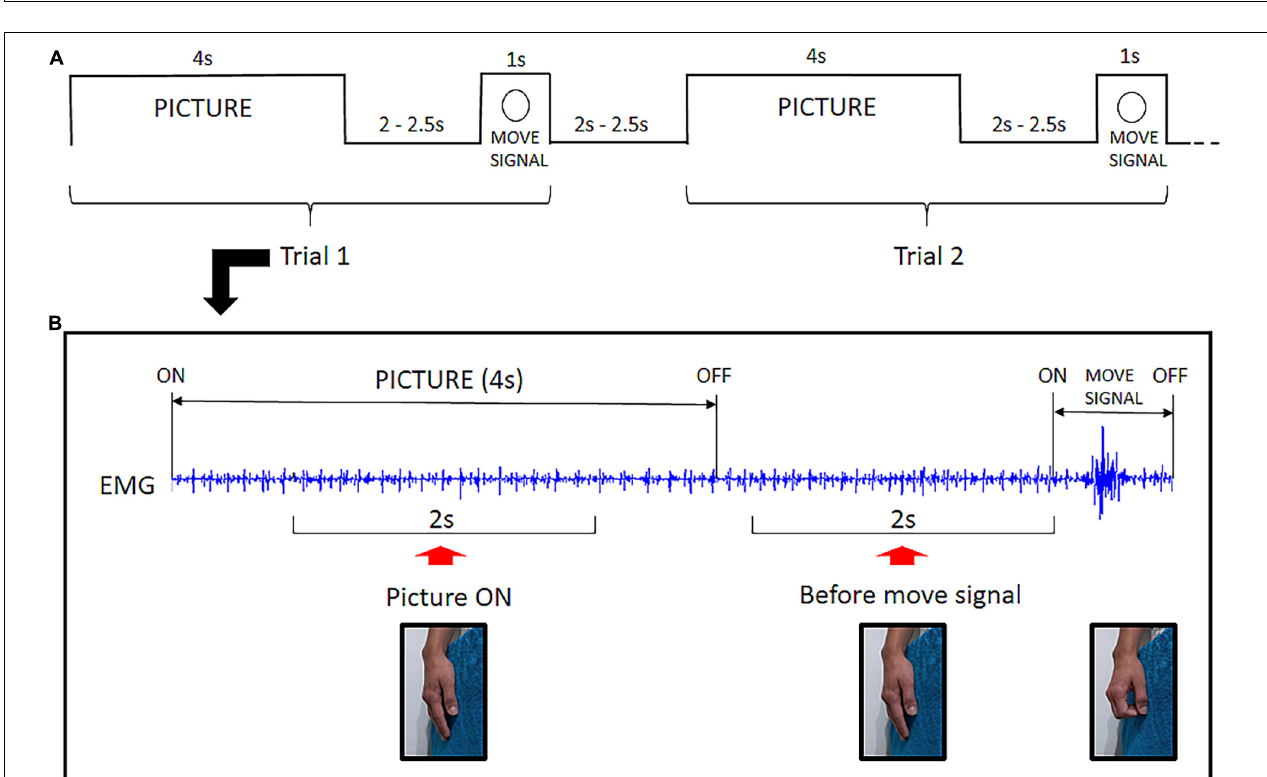
FIGURE 1 | Schematic diagram of the experimental setup. (A) Participant‘s positioning during the experimental session. (B) Three examples of visual stimuli pairs. Pictures at the right side depict the interacting bonding dyads and those at the left side, their respective matched non-interacting controls. In the experimental session the eyes in the pictures were not covered.